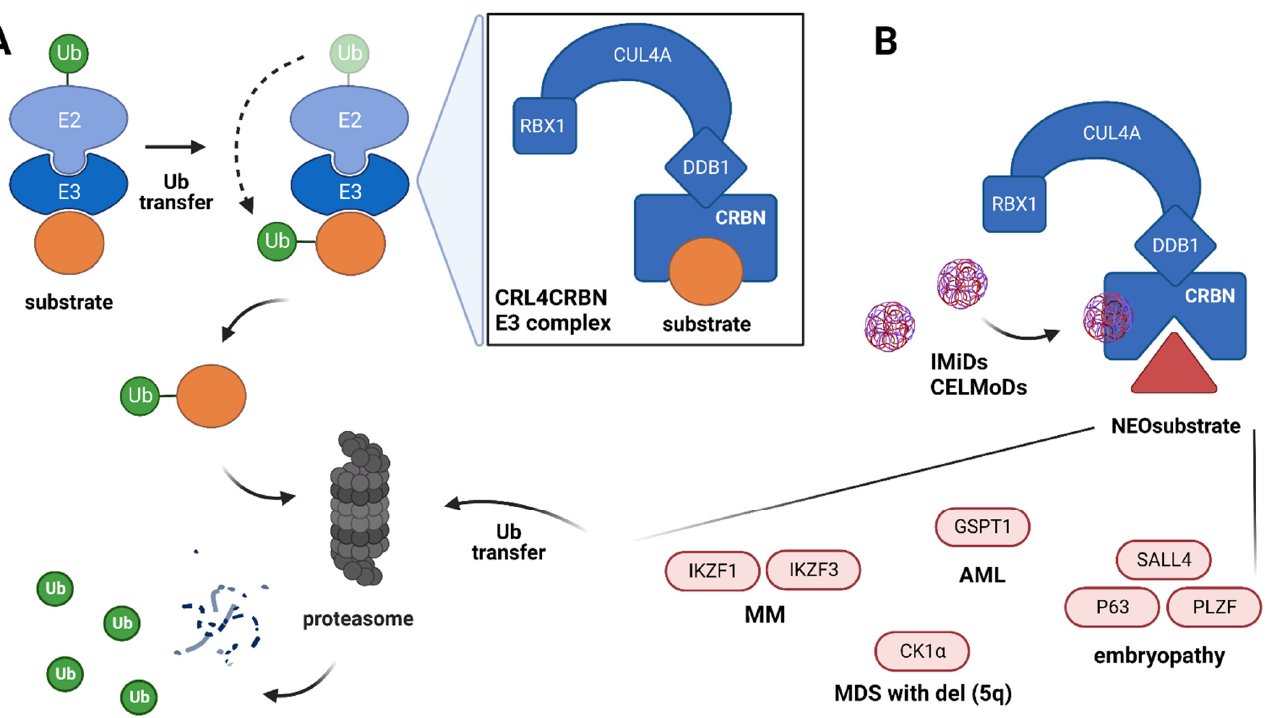
Figure 1. ( A ) Overview of the ubiquitination process via CRL4 CRBN E3 ligase complex. The E3 ligase recognizes the E2-Ub complex and target substrate with subsequent transfer of Ub from E2 to the substrate. This process results in Ub-substrate transfer to the proteasome and proteolytic degradation with Ub recycle. The CRL4 CRBN E3 ligase complex (enlarged) is formed by cereblon (CRBN)—a substrate recruiter, and other proteins such as DNA damage binding protein 1 (DDB1), cullin 4A (CUL4A), and regulator of cullins-1 (RBX1). ( B ) Mechanism of CRBN-mediated effects upon exposure of different substrates (neosubstrates) for ubiquitination and successive protein